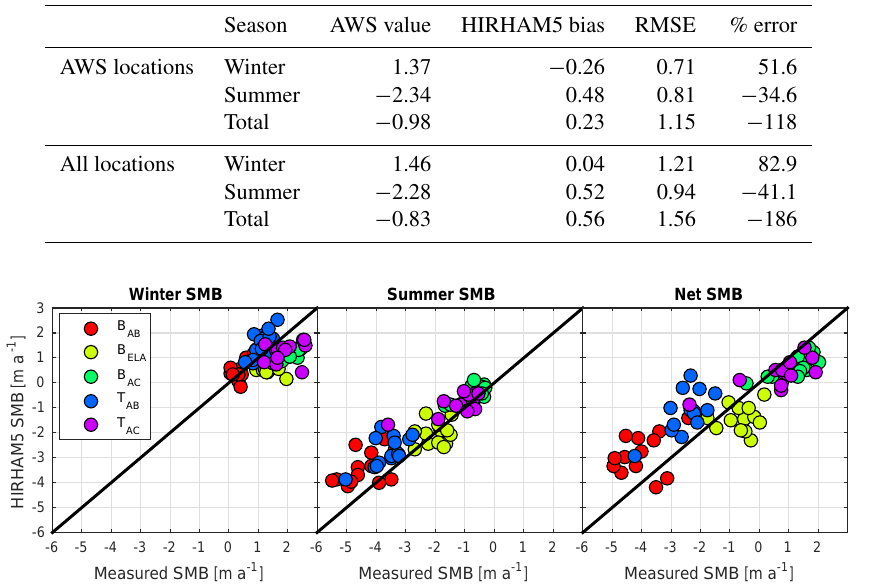
Table 4. Comparison of HIRHAM5 and mass balance measurements, both at AWS sites and for all measuring sites on Vatnajökull.